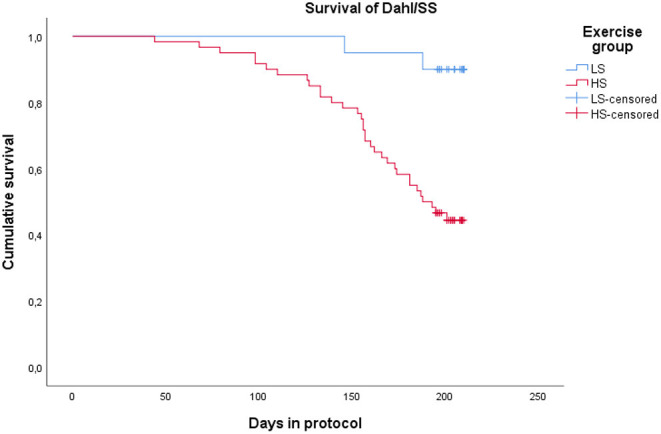
Kaplan-Meyer plot showing survival of Dahl/SS on a low-salt vs. a high-salt diet. Termination at the end of protocol is censored.